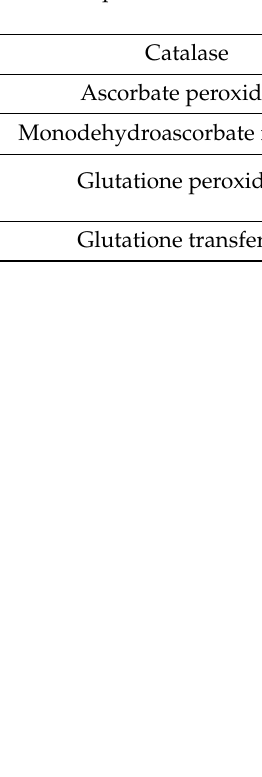
Table 4. Major enzymatic ROS scavengers in the antioxidant mechanisms. RX = redoxin, DHA = dehydroascorbate, AsA = ascorbate, MDHA = monodehydroascorbate. Adapted from ref. [8]. Scavenger Acronym Catalyzed Reaction Superoxide